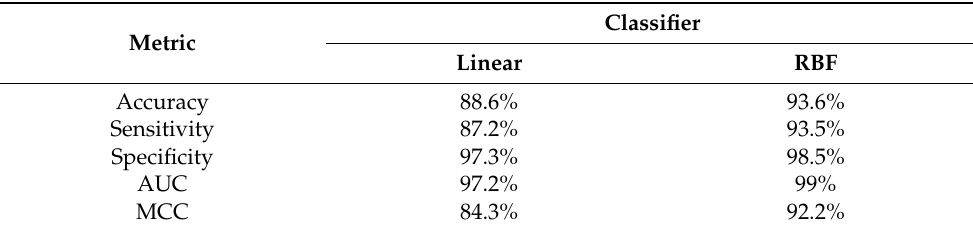
Table 4. Comparison of the overall performance between the SVM with a linear kernel and an RBF kernel.